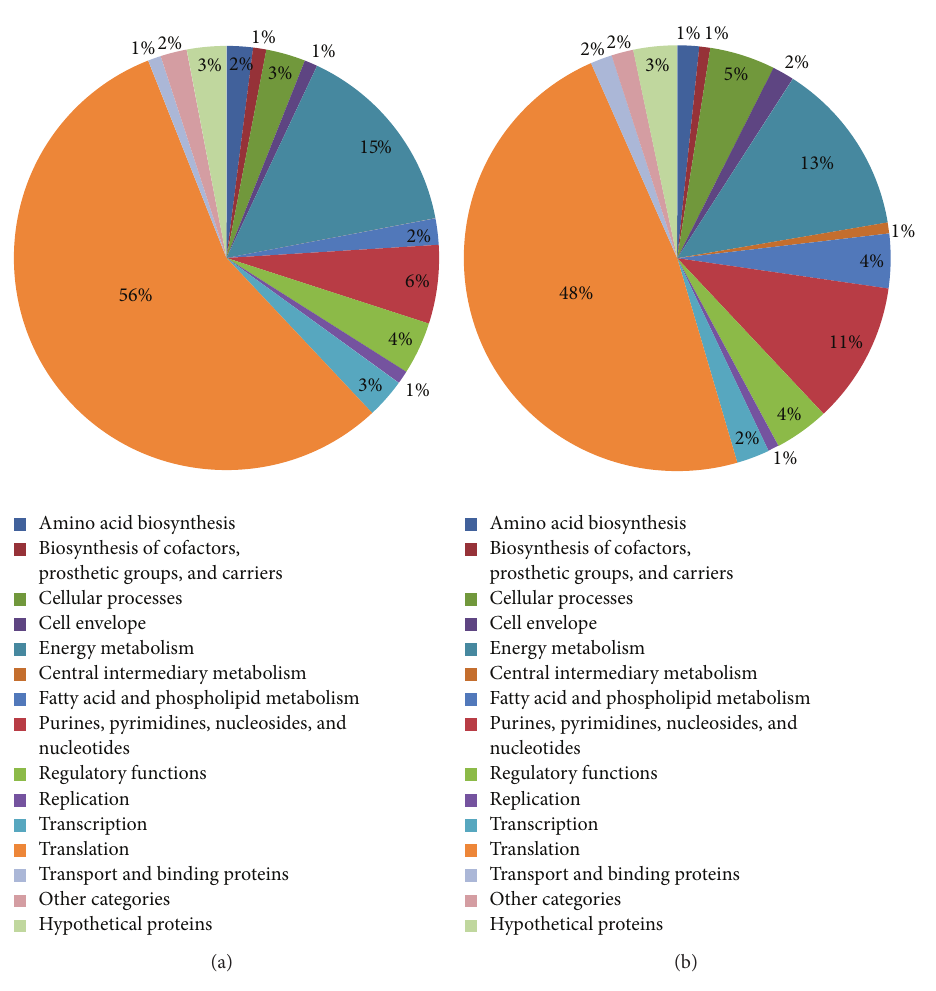
Figure2:Functionalattributionsofthegrowthphase-dependentproteomesof L. lactis strainM4.Panel(a),thepiechartshowsthefunctional attributions of L. lactis M4 proteome during the mid-exponential growth phase (OD 600 ∼ 0.8 ); Panel (b), the early stationary growth phase (OD 600 ∼1.8